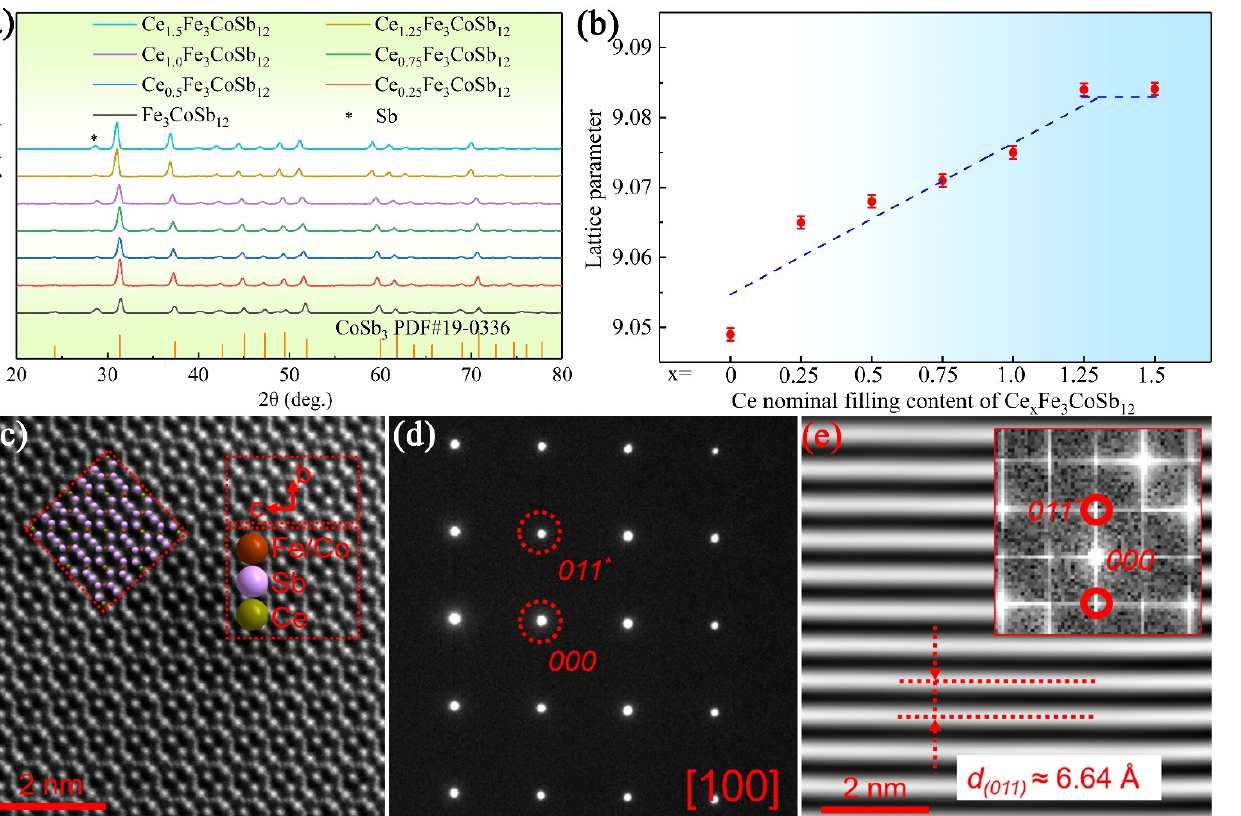
Figure 2. ( a ) XRD diffraction patterns and ( b ) Lattice parameter a of the as-prepared Ce x Fe 3 CoSb 12 (x = 0 to 1.5). ( c ) HAADF image with an inserted 2 × 2 × 2 supper cell model, ( d ) SAED pattern in ( c ) and ( e ) Inverse pole figure (IPF) maps in CeFe 3 CoSb 12 . The EBSD IPF maps in ( f ) normal direction, ( g ) rolling direction and ( h ) transverse direction of the Ce 1.25 Fe 3 CoSb 12 .